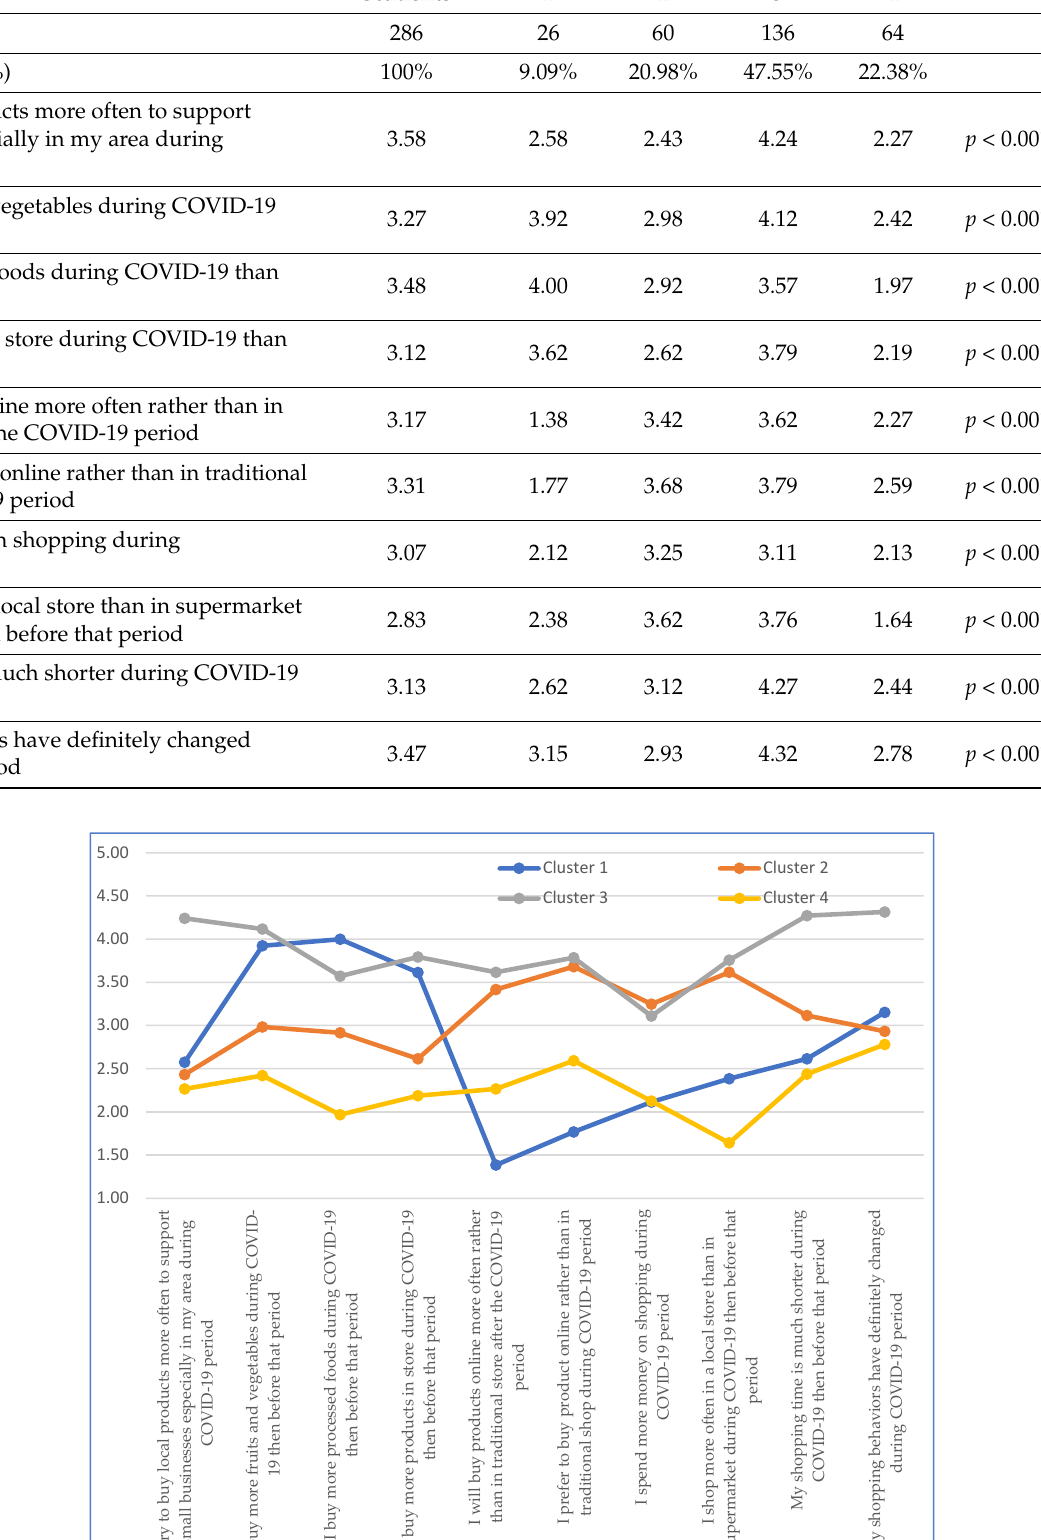
Table 7. Cluster analysis: European students.